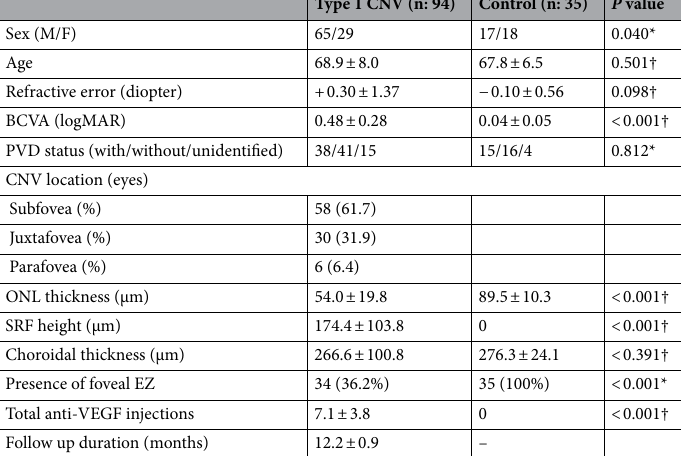
Table 1. Baseline characteristics of type 1 CNV patients and the control group. CNV choroidal neovascularization, BCVA best-corrected visual acuity, logMAR log of minimum angle of resolution, ONL outer nuclear layer, SRF subretinal fluid, VEGF vascular endothelial growth factor, PVD posterior vitreous detachment. * P value was calculated using the Chi-square analysis. † P values were calculated using the Student’s t